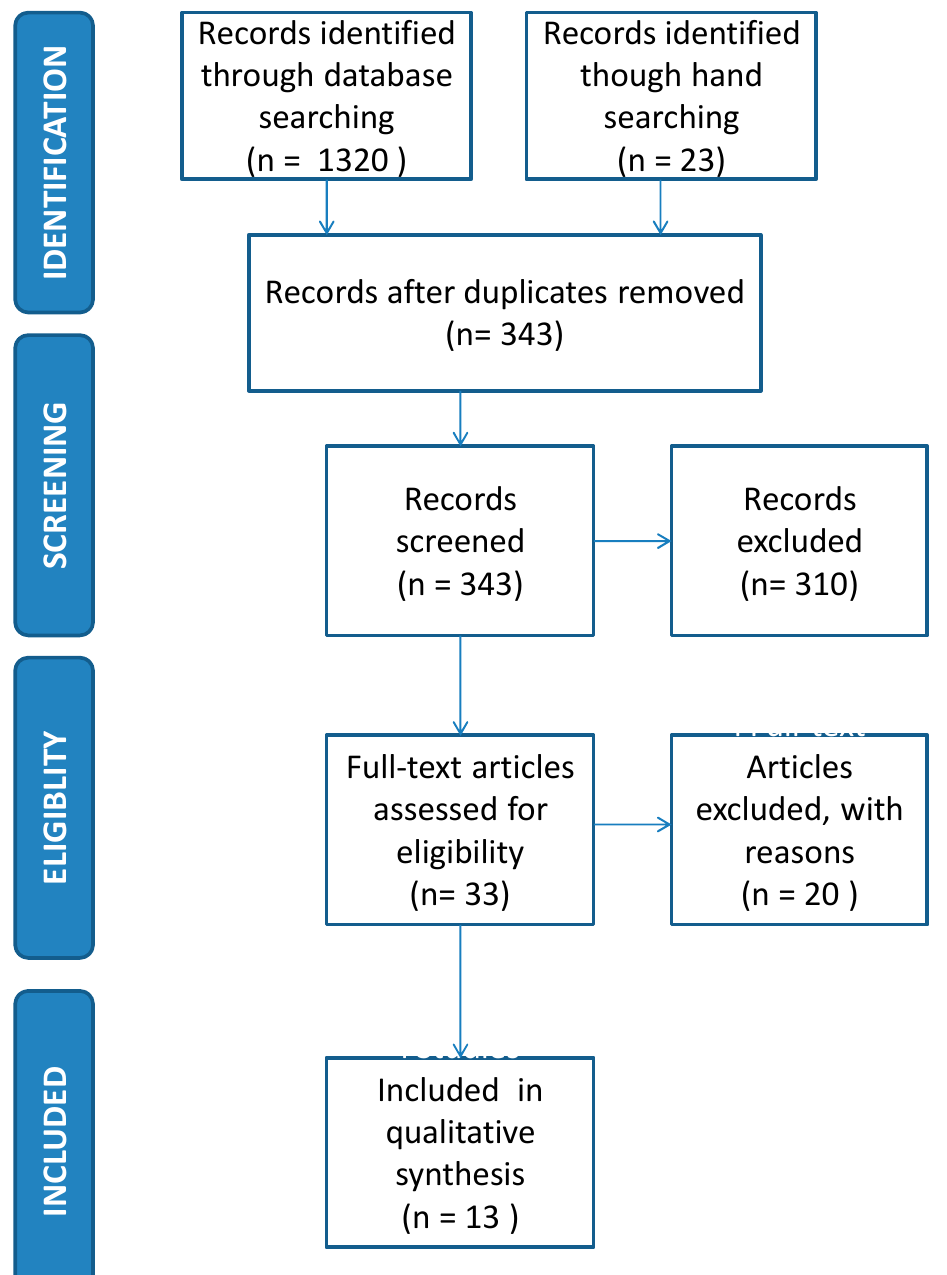
Figure 1. Flowchart on number of articles selected in the systematic review based on eligibility